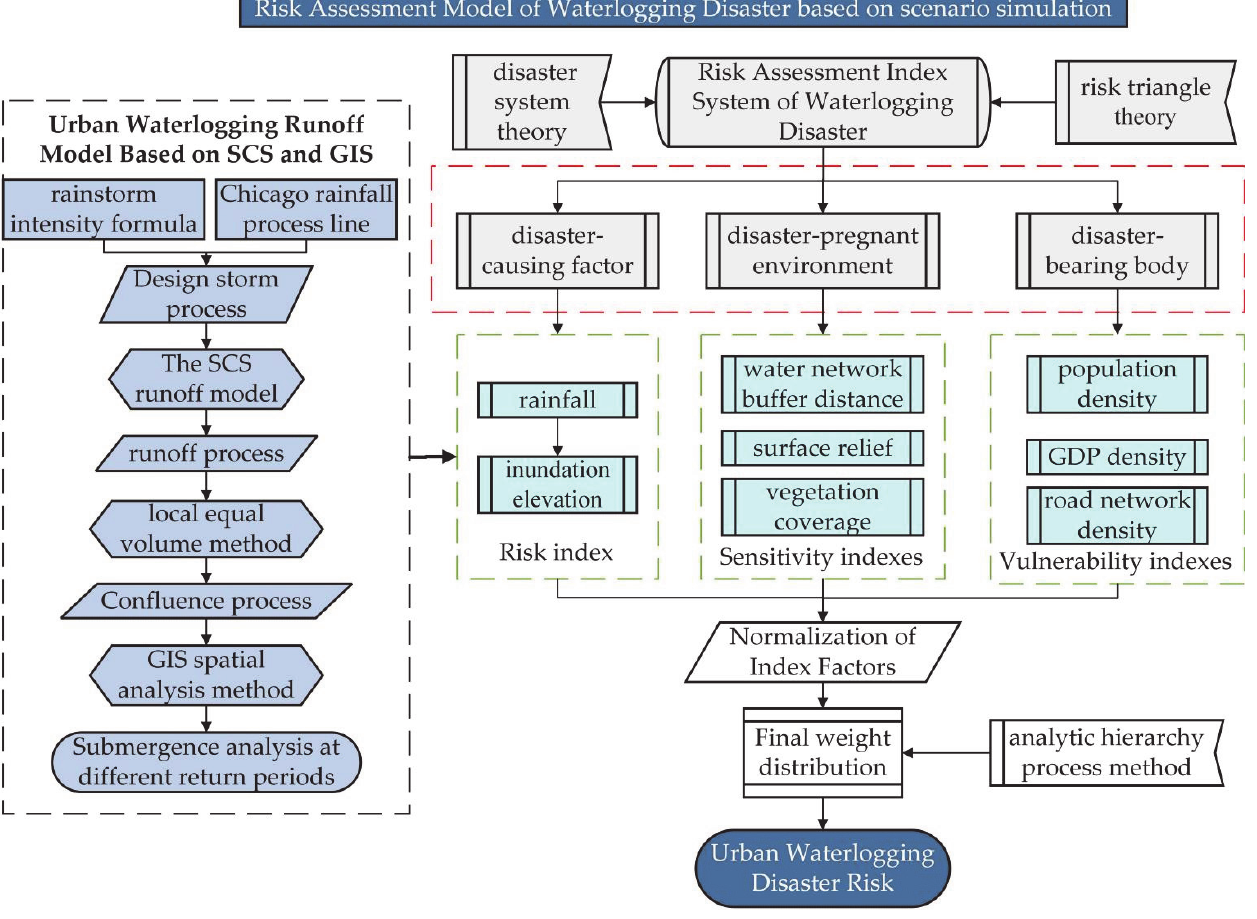
Figure 2. The overall framework of waterlogging disaster risk